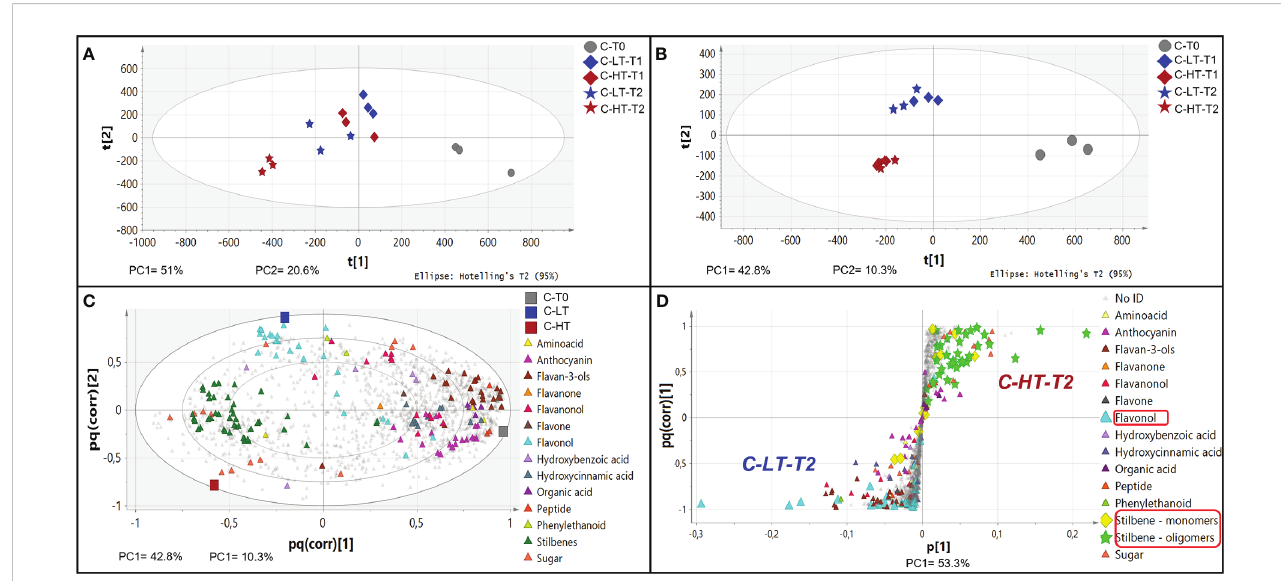
FIGURE 4 Non-volatile metabolite pro fi le of grapes dehydrated in the C-HT and C-LT rooms. (A) PCA score scatter plot of non-volatile metabolites from berries collected during postharvest dehydration under C-HT and C-LT conditions. (B) O2PLS-DA score scatter plot highlighting a good sample clustering based on the withering conditions. (C) O2PLS-DA loading plot showing metabolites (triangles) featuring the mature phase (T0) and metabolites featuring drying berries collected in the C-HT and C-LT rooms. For this analysis, the T1 and T2 samples were grouped together. (D) OPLS-DA S-loading plot showing metabolites (triangles) correlating with the high or the low-temperature-condition at the end of the process (T2). Concerning stilbenes, monomeric forms are highlighted with yellow diamonds, whereas oligomers are shown as green